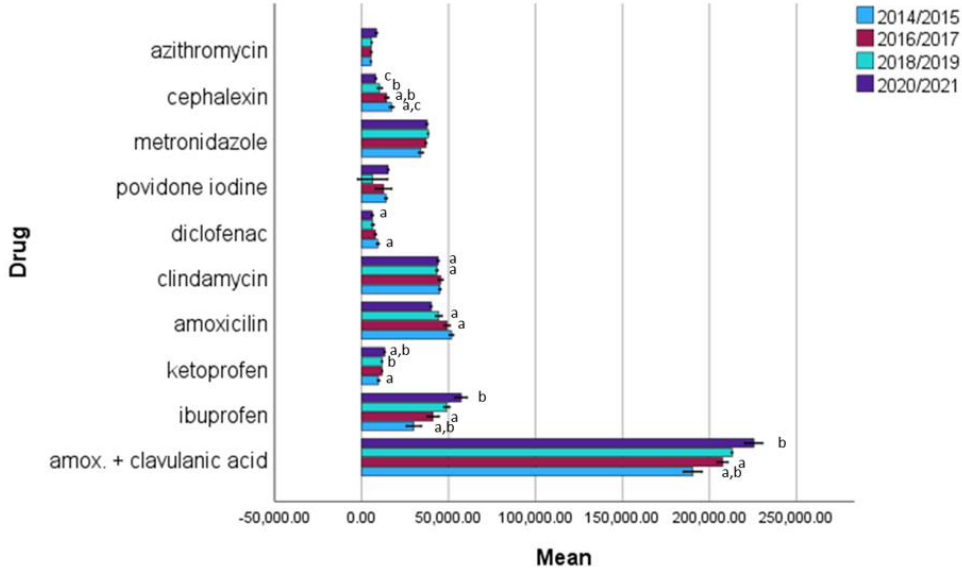
Figure 1. Descriptive statistics of drug prescription in time intervals (2014/15, 16/17, 18/19, 20/21). Same letters indicate statistically significant values for comparisons among year intervals. Error bars denote ± 1 SD.